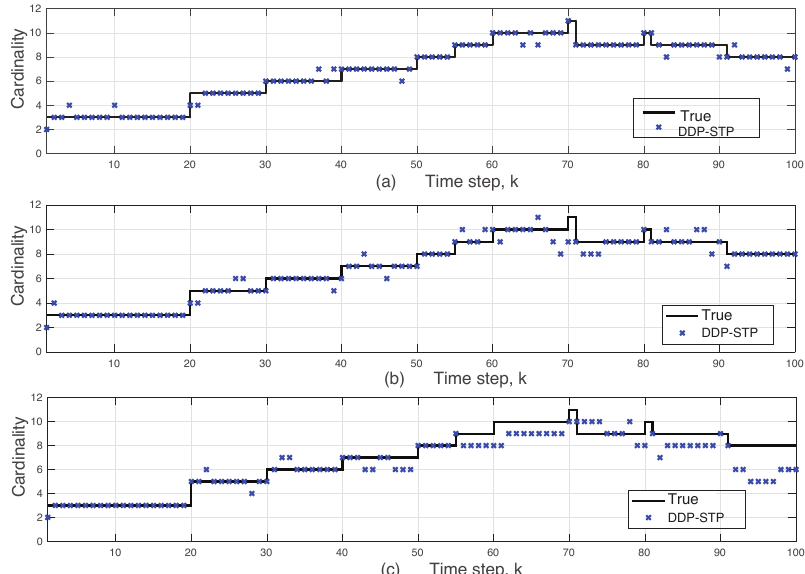
Figure 8. Comparison of true and estimated object cardinality using DDP-STP for ( a ) − 3 dB, ( b ) − 5 dB, and ( c ) − 10 dB SNR in Experiment 3.